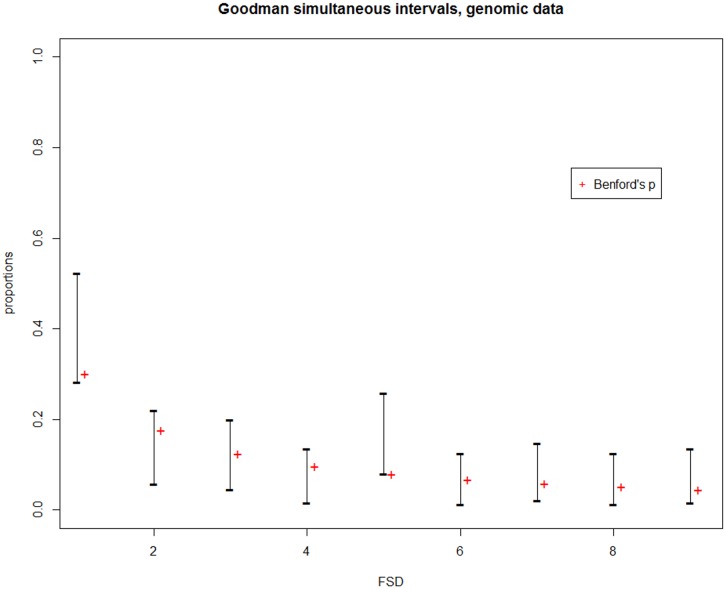
Goodman simultaneous confidence intervals for the genomic data.Vertical line segments denote the Goodman simultaneous confidence intervals computed from the Genomic data in Table 5. The red crosses are positioned at the Benford probabilities.